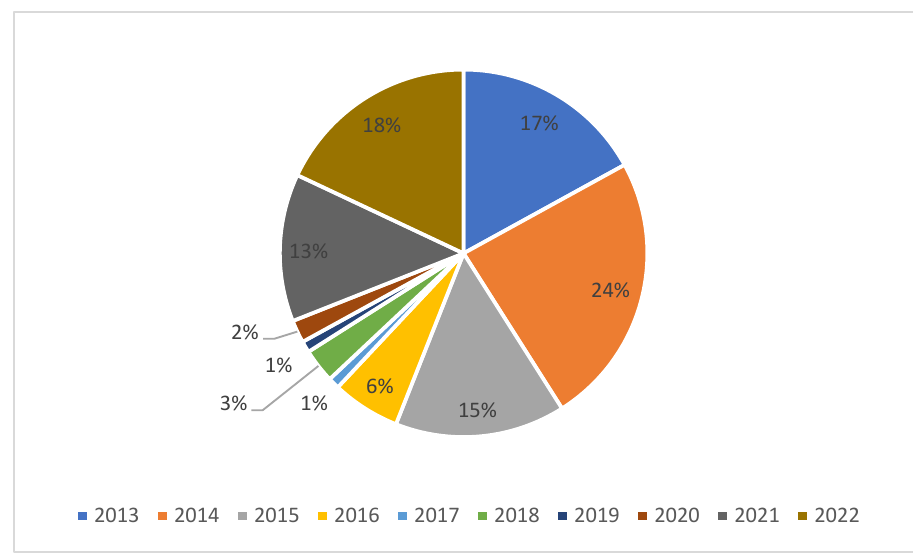
Figure 1. The percentage of papers covered from 2013 to 2022.